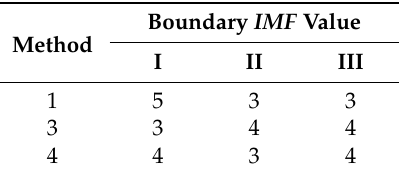
Table 2. The boundary IMF of Methods 1, 3, and 4 in three simulation